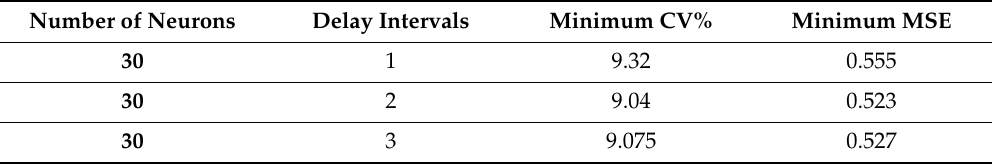
Table 4. Fan Power Model Optimization Results.